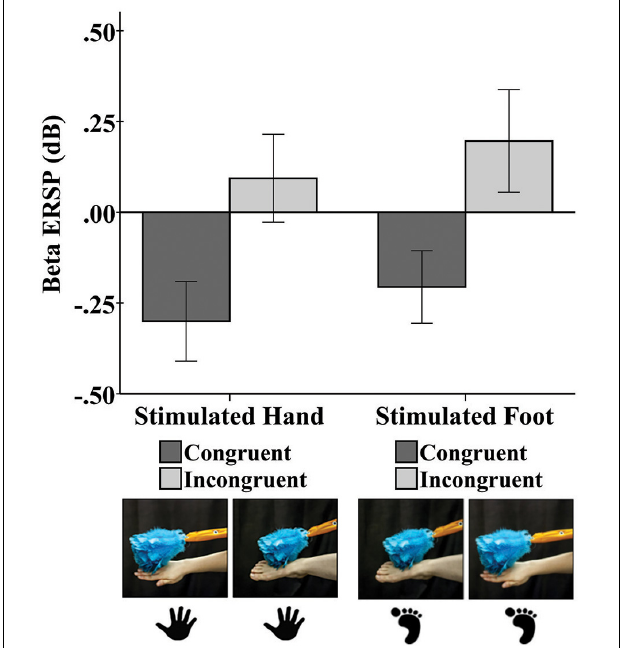
FIGURE 2 | Mean beta rhythm ERSP at central electrode sites in response to tactile stimulation of the infant’s right hand and the infant’s right foot during the early time window (0–500 ms). Hand and foot icons indicate the infant body part receiving direct tactile stimulation. Photographs indicate which event the infant visually observed in the live demonstration. Error bars represent ± 1 standard